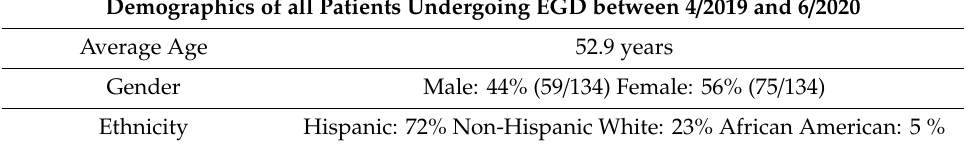
Table 1. Demographics data of the 134 patients who underwent upper endoscopies over the 15-month period of the study.